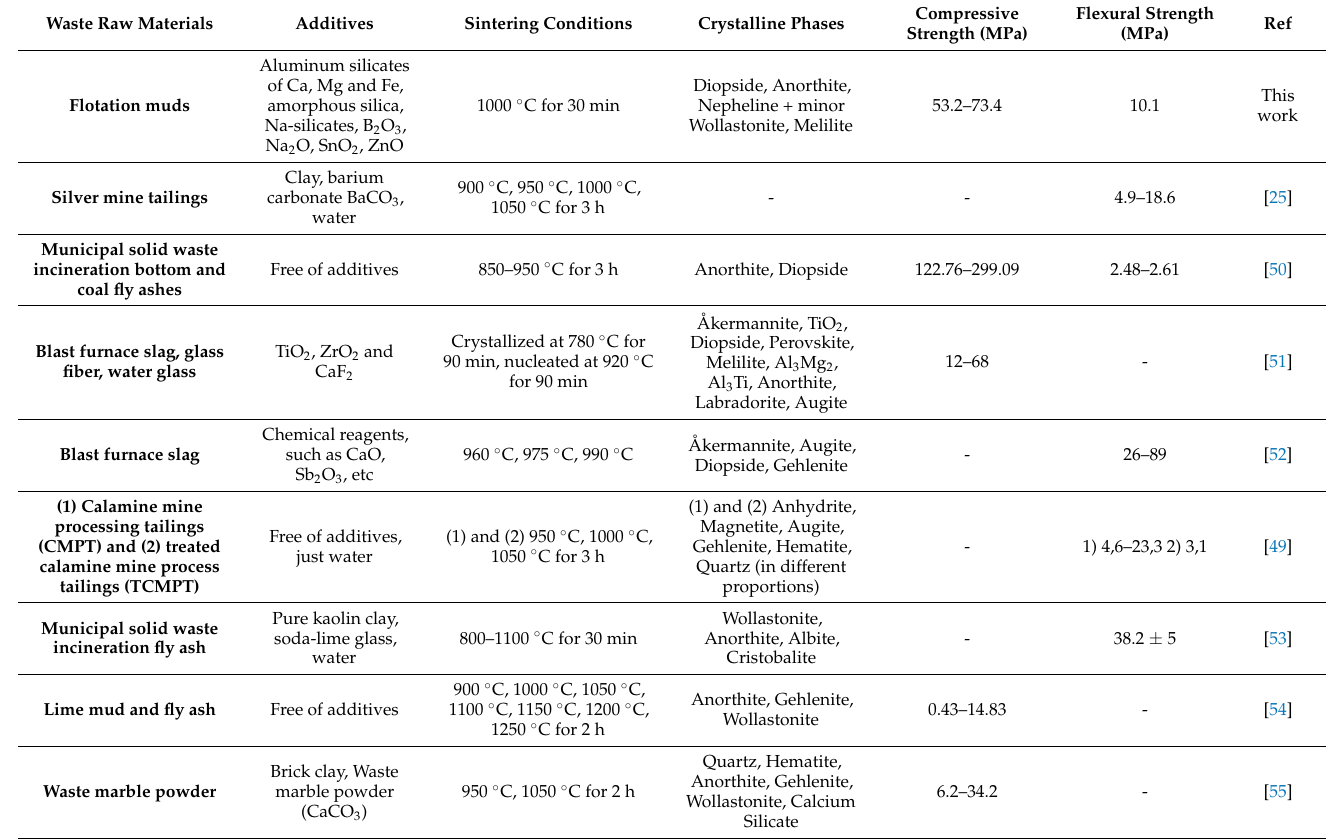
Figure 8. Three-dimensional tortuosity factor analysis with TauFactor. ( a ) Schematic vision of the investigated 3D subvolume: the model calculates the connectivity of the cross section of each pore (white areas in the image) from the top image to the bottom along the tested axis and in the three mutually perpendicular directions. ( b ) Stacked 3D images of modelled interconnected pathways for each tested direction. The intensity of the color is proportional to the concentration of pathways. Table 5. Main characteristics of some ceramic materials obtained from recycling of different kinds of waste (modified after